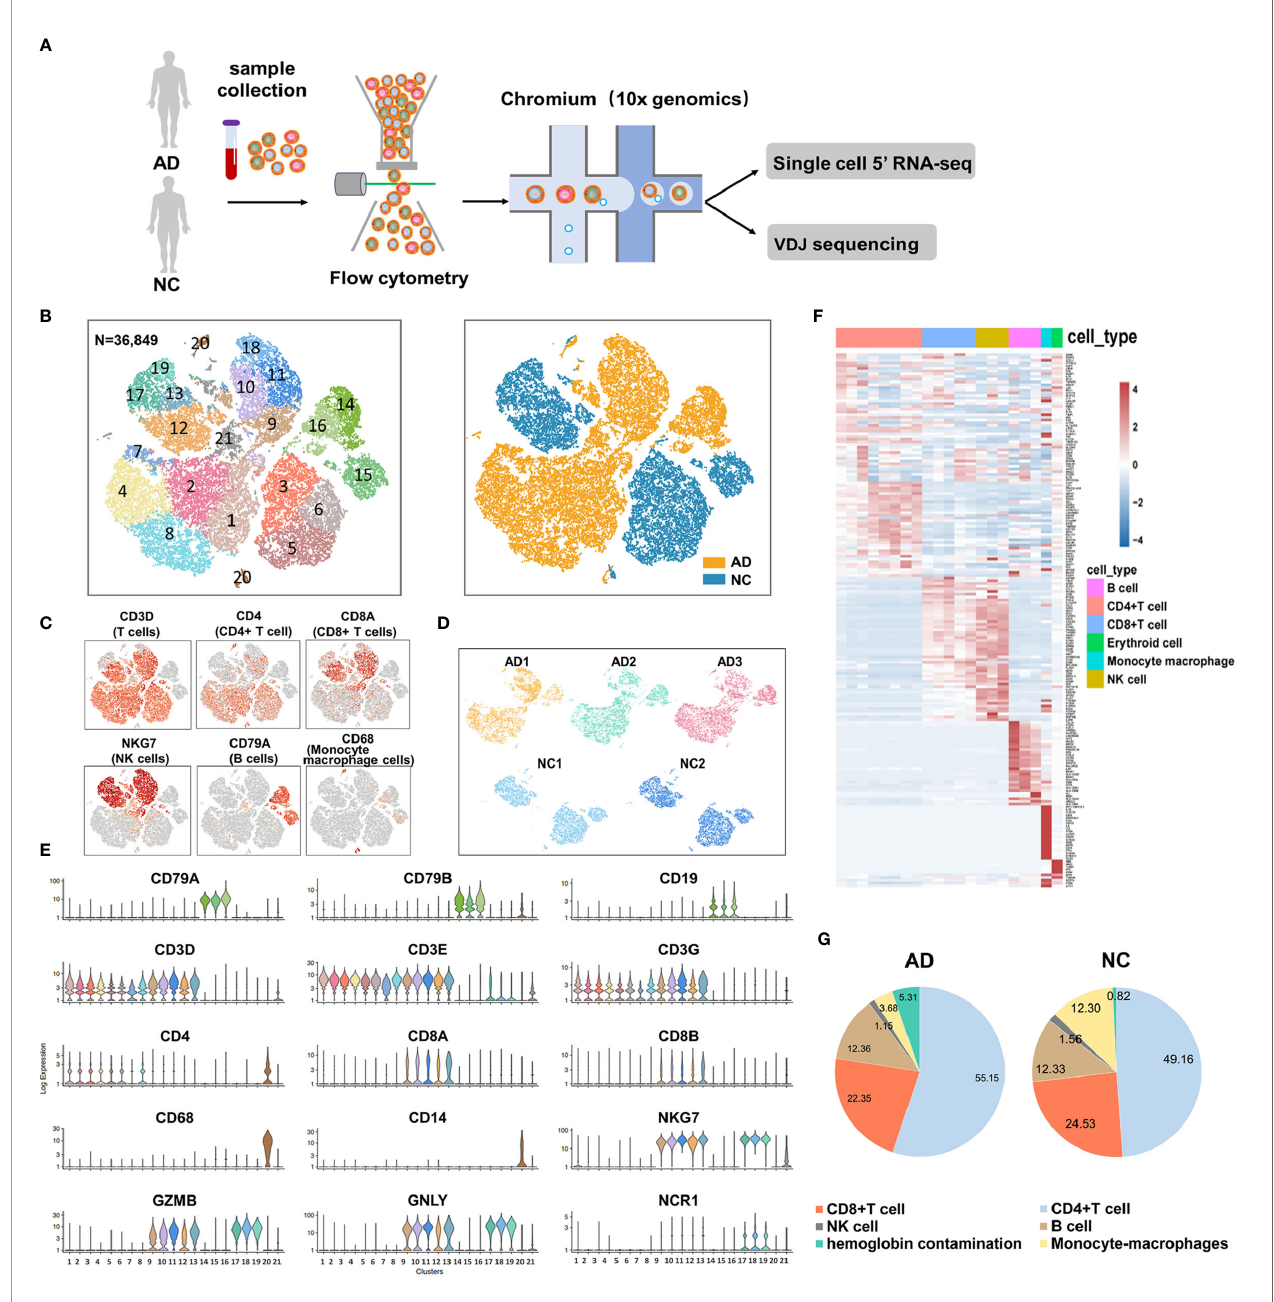
FIGURE 1 | Single-cell gene expression analysis of peripheral blood mononuclear cells (PBMC) in Alzheimer ’ s disease (AD). (A) Experimental work fl ow for single-cell RNA analysis in the present study. (B) tSNE projection of 36,849 cells from PBMCs in the AD group and normal controls (NC). A total of fi ve cell types were shown in (B) , including CD4+ T cells (clusters 1, 2, 3, 4, 5, 6, 7 and 8), CD8+ T cells (clusters 9, 10, 11, 12, and 13); B cells (clusters 14, 15 and 16); Natural killer (NK) cells (clusters 17, 18 and 19) and monocyte-macrophages cells (clusters 20). (C, E) Canonical cell surface markers de fi ne CD4+ T cells, CD8+ T cells, natural killer (NK) cells, B cells, and monocyte-macrophage cells. (D) tSNE projections of cell transcriptome in each sample in this study. (F) Heatmap of the top 20 marker genes from each cluster. (G) Proportion of the fi ve types of immune cells in the AD group and